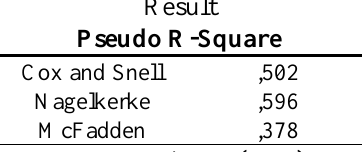
Table 9. Pseudo R-Square